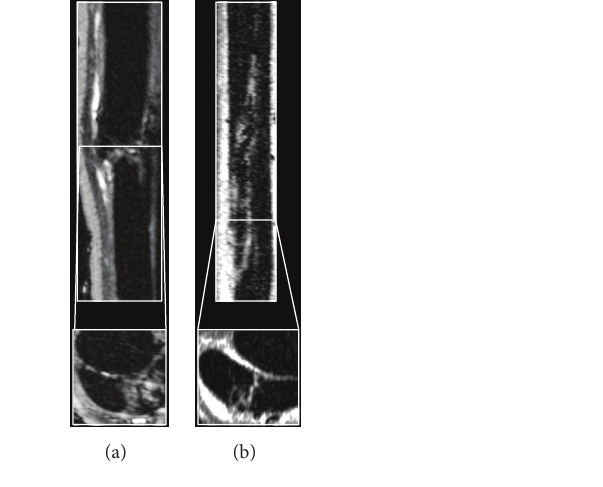
Figure 7: TRUFI images demonstrate SDFT lesions (a) induced immediately prior to and (b) 10 days prior to injection in the sagittal (top) and transverse (bottom)